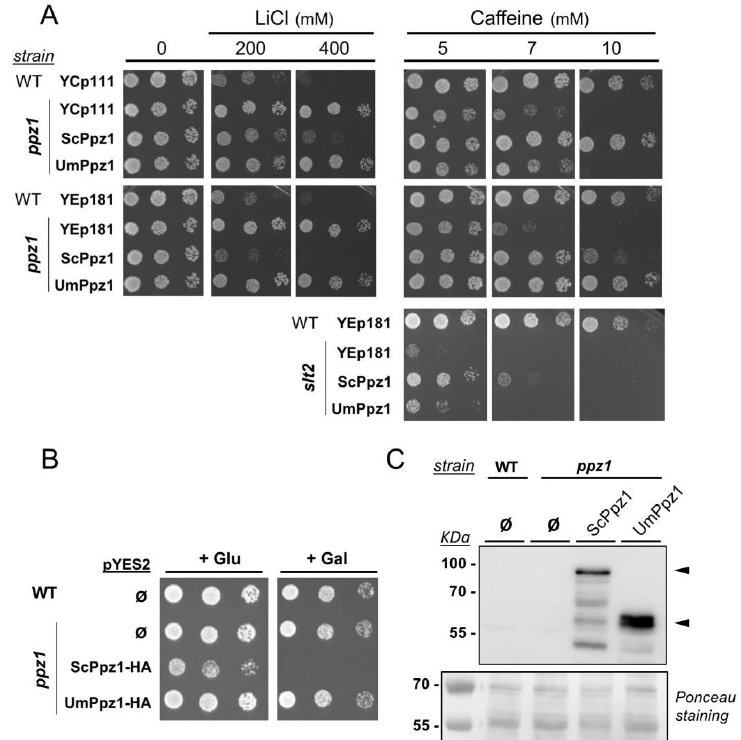
Figure 2. Phenotypic analysis of the expression of UmPpz1 in S. cerevisiae . ( A ) The wild type BY4741 strain (WT) and its ppz1 and slt2 derivatives were transformed with YCplac111 (centromeric, LEU2 marker), or YEplac181 (episomal, LEU2 marker) plasmids carrying S. cerevisiae (ScPpz1) or U. maydis (UmPpz1) phosphatases. Cultures were spotted at OD 660 = 0.05 and at 1 / 5 dilutions on synthetic medium plates lacking leucine and containing the indicated amounts of LiCl or caffeine. Plates were grown for 4 days. Ø, empty plasmid. ( B ) Wild type and ppz1 strains were transformed with empty pYES2 plasmid (pYES2-Ø) or the same plasmid expressing ScPpz1-HA or UmPpz1-HA from the GAL1 promoter. Cells were grown on synthetic medium lacking uracil supplemented with 2% glucose and spotted on the same plates containing either 2% glucose or 2% galactose. Growth was monitored after 2 days. ( C ) The same strains were grown in liquid medium with 2% galactose. Samples were taken after 6 h and processed for SDS-polyacrylamide gel electrophoresis (SDS-PAGE) as described. 80 µ g of protein were electrophoresed in 10% SDS-polyacrylamide gels, transferred to membranes and probed with anti-HA antibodies to detect the tagged proteins (arrowheads). Ponceau staining of the membranes was carried out (lower panel) to monitor for correct loading and